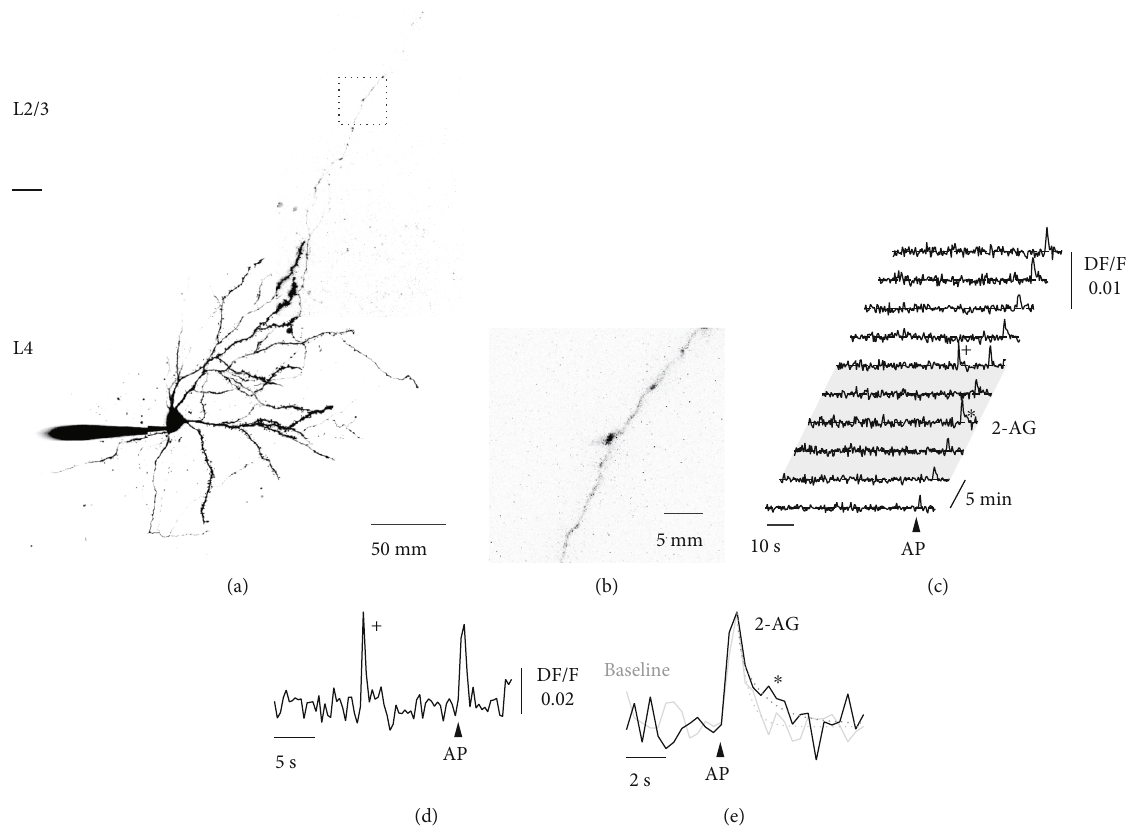
Figure 2: Presynaptic Ca 2+ imaging in L4 spiny stellate axons. (a) Two-photon fl uorescence image of a spiny stellate neuron in L4 of the somatosensory cortex loaded with OGB-1 and Alexa-594. (b) Imaged axon segment in L2/3 indicated in (a) by the dashed box. (c) Consecutive fl uorescence traces of 1min duration repeated every 5 min before, during (shaded area) and after bath application of 2-AG. An arrowhead indicates the time point of a somatically evoked AP. (d) Spontaneous axonal Ca 2+ transient marked by a cross in (c) on an expanded scale. The Ca 2+ transient was unrelated to somatic activity. (e) AP-evoked Ca 2+ transient in the presence of 2-AG marked by an asterisk in (c) on an expanded scale (black) compared to an AP-evoked Ca 2+ transient during baseline (grey). Dashed lines present single exponential fi ts to the decay of the Ca 2+